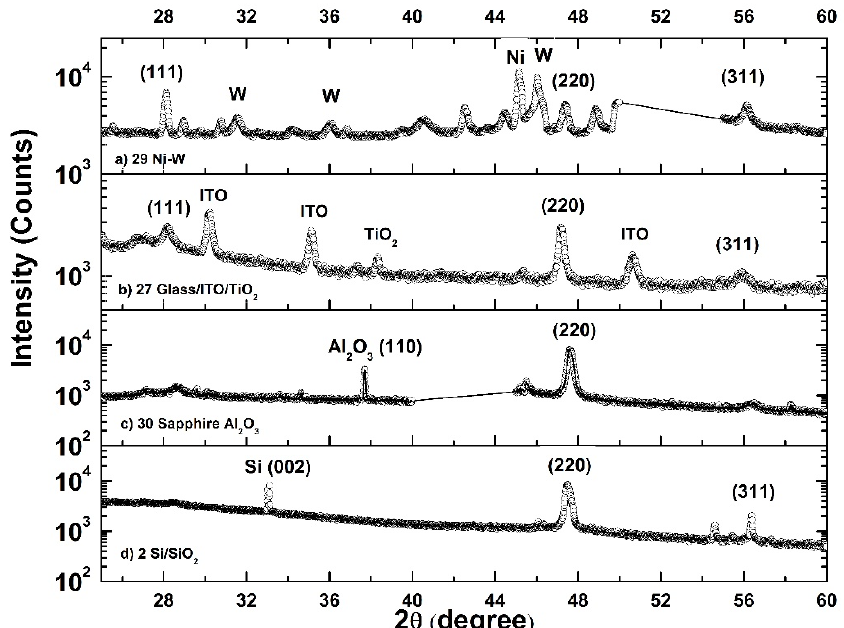
Figure 3. Diffraction spectrum of thick boron-doped polycrystalline silicon film on ( a ) 29_Ni-W-pSi, ( b ) 27_ Glass/ITO/TiO 2 -pSi, ( c ) 30_Sapphire-pSi (Al 2 O 3 ), and ( d ) 2_Si/SiO 2 -pSi substrate.